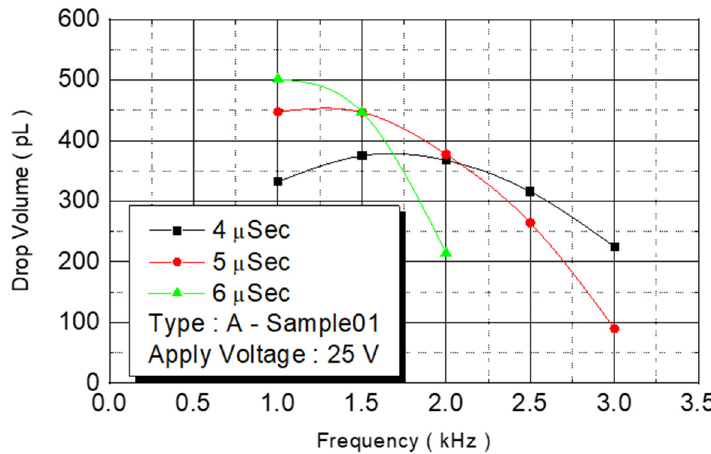
Figure 11. A Type - Sample01 drop volume.